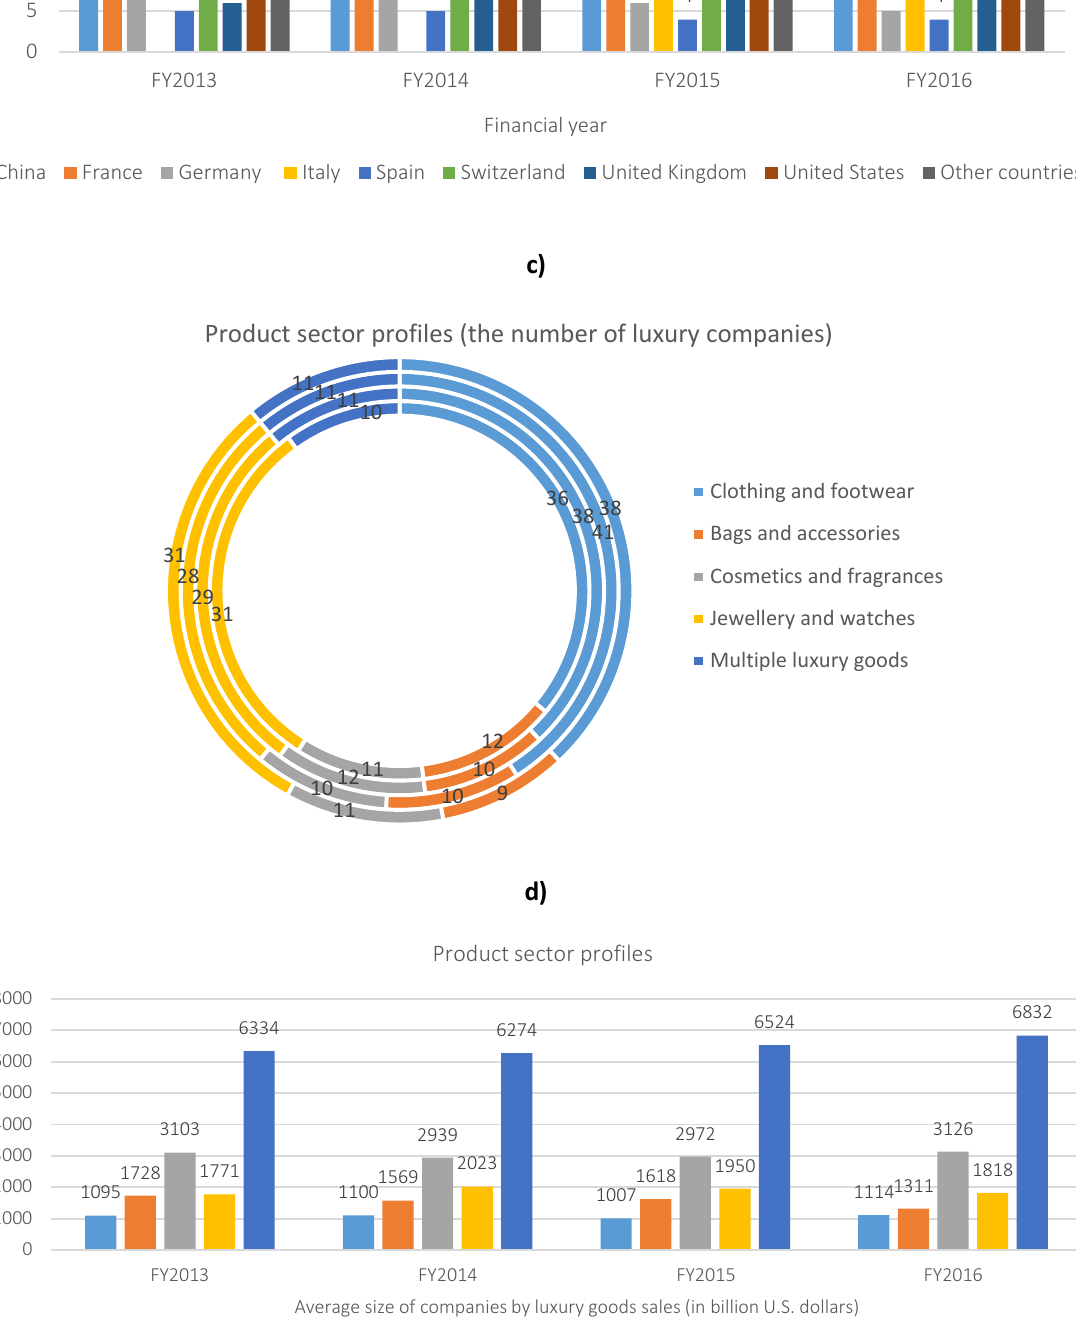
Figure 2. The portrait of worldwide luxury market from 2013 to